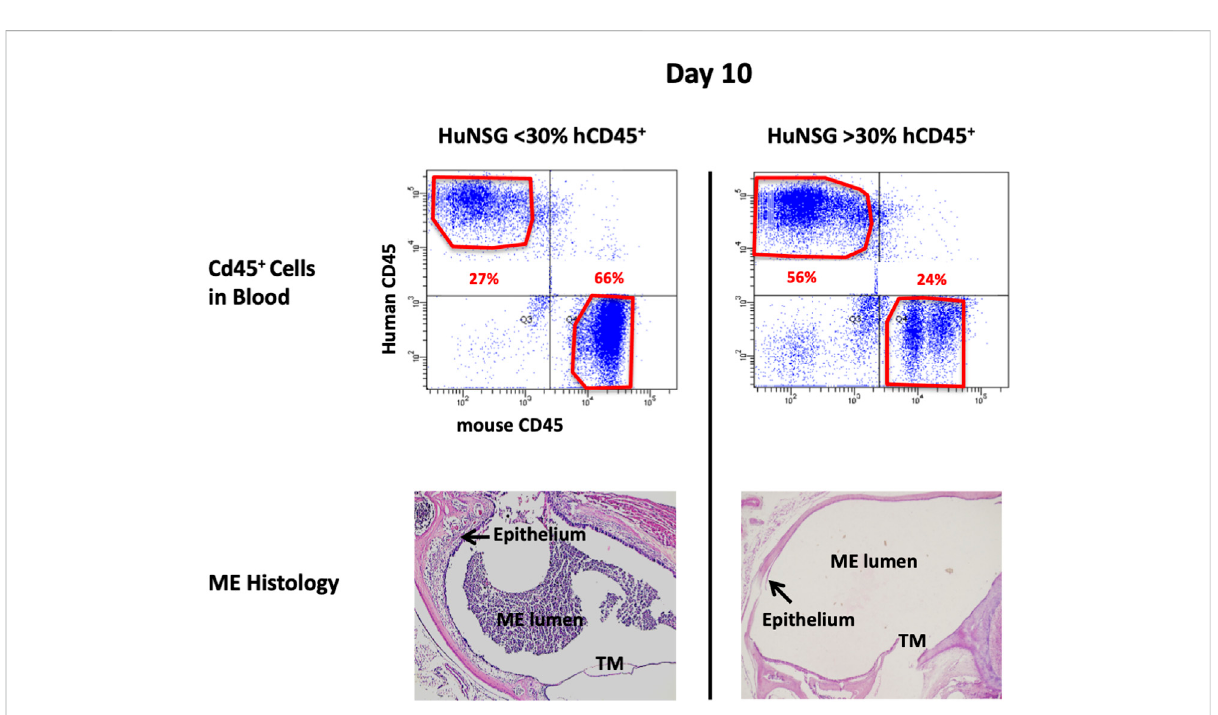
FIGURE 4 Degree ofengraftmentlevels with human CD45 + cell impacts effective and appropriate bacterial clearance. Representative histological images of the middle ear of HuNSG mice that had less than 30% human CD45 + leukocytes (in blood) appeared incompetent to clear OM by 10 days. Humanized mice that had greater than 30% human CD45 + cells in blood however, appeared to have resolved OM by day